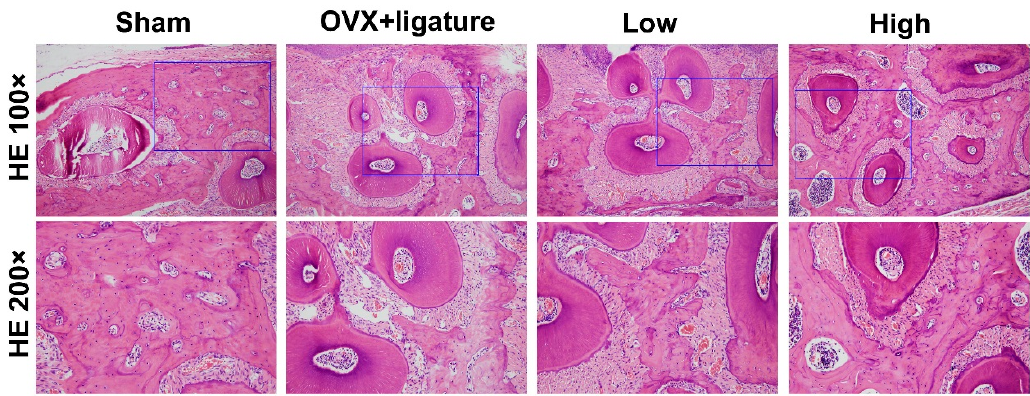
Figure 3. Descriptive analysis of hematoxylin and eosin (H&E) staining in paraffin sections; images show cross sections of each group at 100× and 200× magnification ( n = 6).